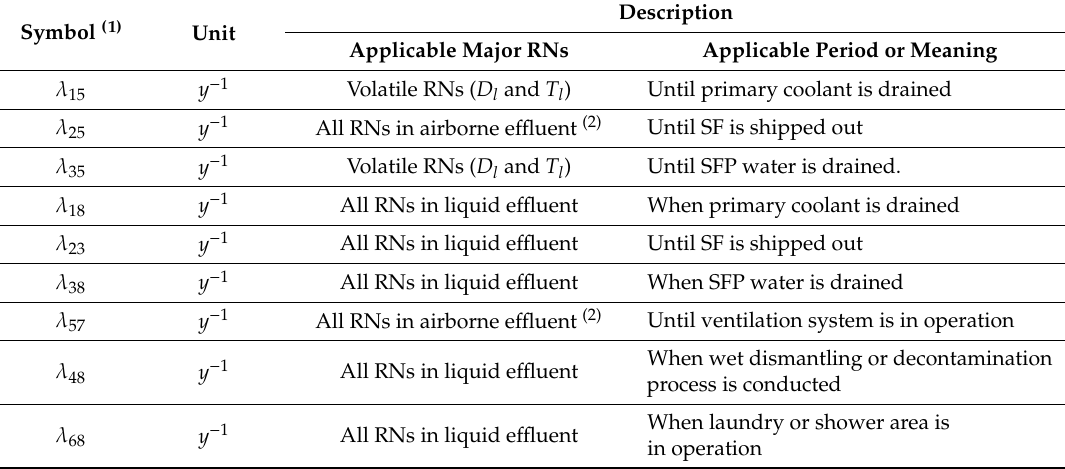
Table 3. Symbols and parameters used in source term model for radioactive e ffl uent in Figure 1 and relevant